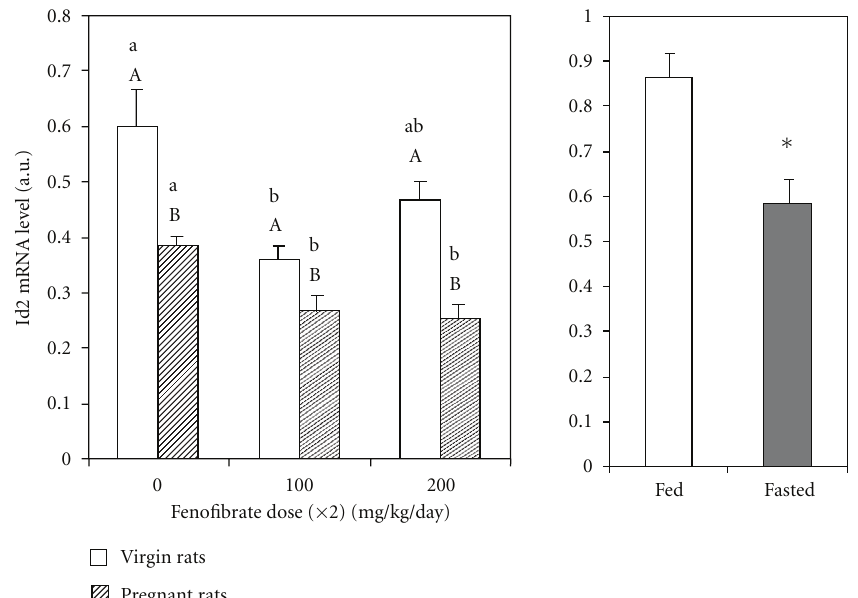
Figure 1: Fenofibrate downregulates Id2 gene expression in rats. Left panel: relative amount of mRNA of liver Id2, after 4-day treatment with or without fenofibrate in virgin and pregnant rats, measured by semiquantitative RT-PCR. Values were normalized against glyceraldehyde- 3-phosphate dehydrogenase (GAPDH) expression and were represented using arbitrary units. Capital letters correspond to the statistical comparisons between pregnant and virgin rats receiving the same treatment. Small letters correspond to the statistical comparisons between rats receiving di ff erent drug doses. Values not sharing a common letter are significantly di ff erent at P < 0 . 05. Each value represents the mean ± standard error of five animals. Right panel: starvation downregulates Id2 gene expression. Relative amount of mRNA of liver Id2 from pregnant rats fed with standard pellet or fasted 24 h, measured by semiquantitative RT-PCR. Values were normalized against GAPDH expression and were represented using arbitrary units. Asterisk represents significantly di ff erent at P < 0 .